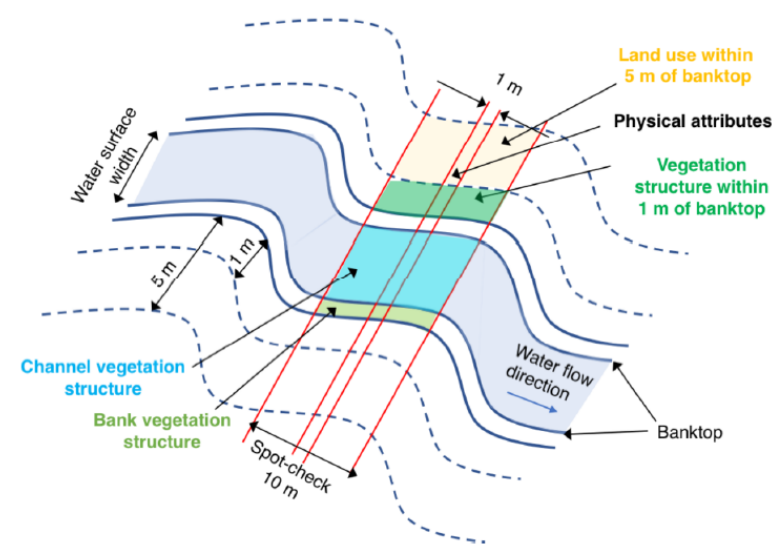
Figure 2. Diagram showing elements for spot-checks. Source: